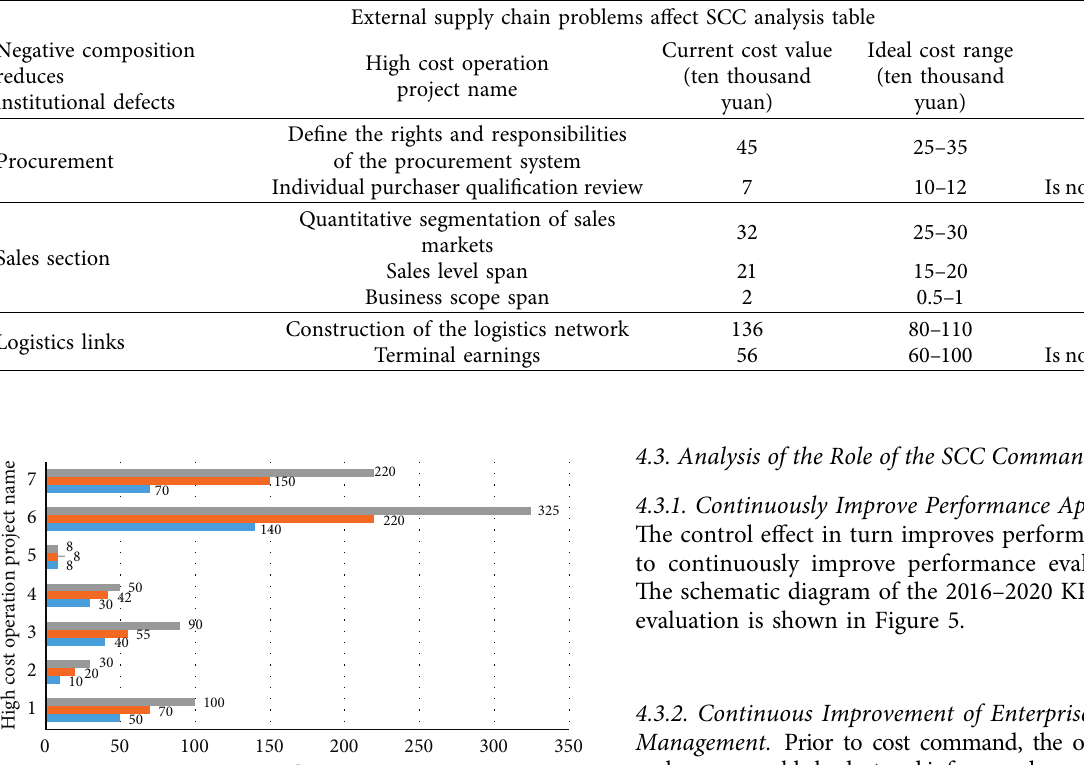
Table 2: Cost analysis table of internal supply chain problems affecting supply chain.